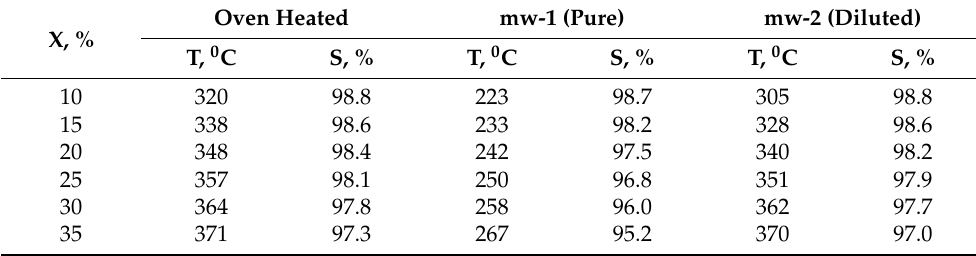
Table 3. Temperatures of X%-conversion of ethane (T) and corresponding values of selectivity